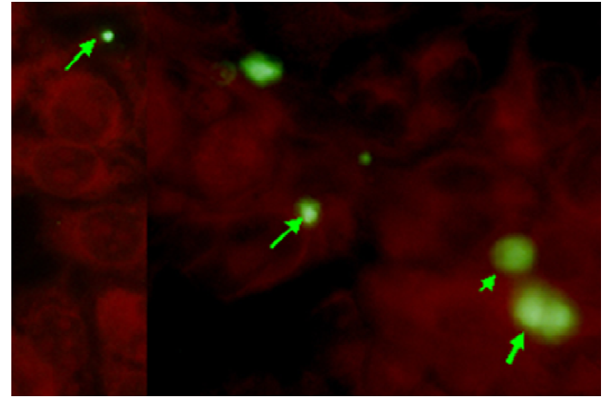
Figure 5. Are these hypnozoites? HepG2-A16 cells were infected, maintained for 9 days as described in Fig 4 and stained with PvCSP mAb. Approximately 10% of the Pv liver stage parasites that expressed PvCSP were similar in size to 3-day trophozoites, and much smaller than the 9-day schizonts. Are these hypnozoites?